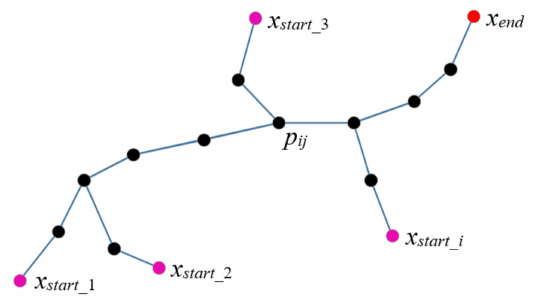
Figure 2. Tree structure of a prior path